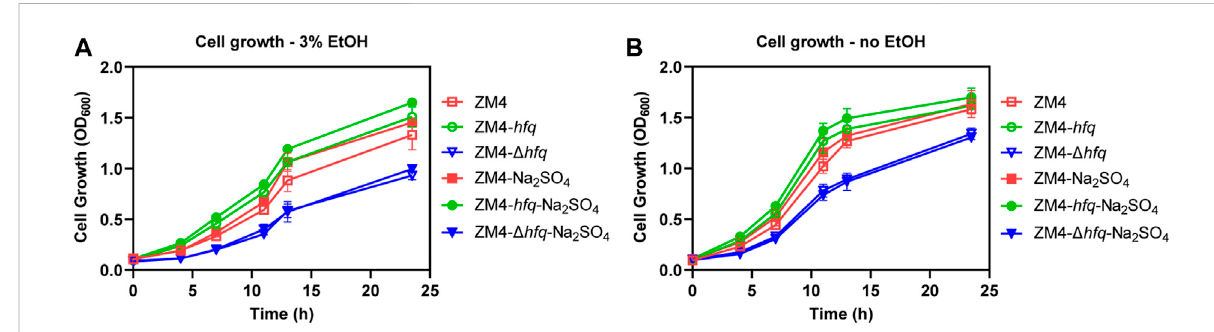
FIGURE 3 Effects of Na 2 SO 4 addition on cell growth of hfq recombinant strains and wild type. 4 g/L Na 2 SO 4 was added in the MM media and cell growths of Z. mobilis hfq recombinant strains were compared with the wild-type strain with (A) or without (B) 3% (v/v) ethanol treatment. EtOH represent ethanol.